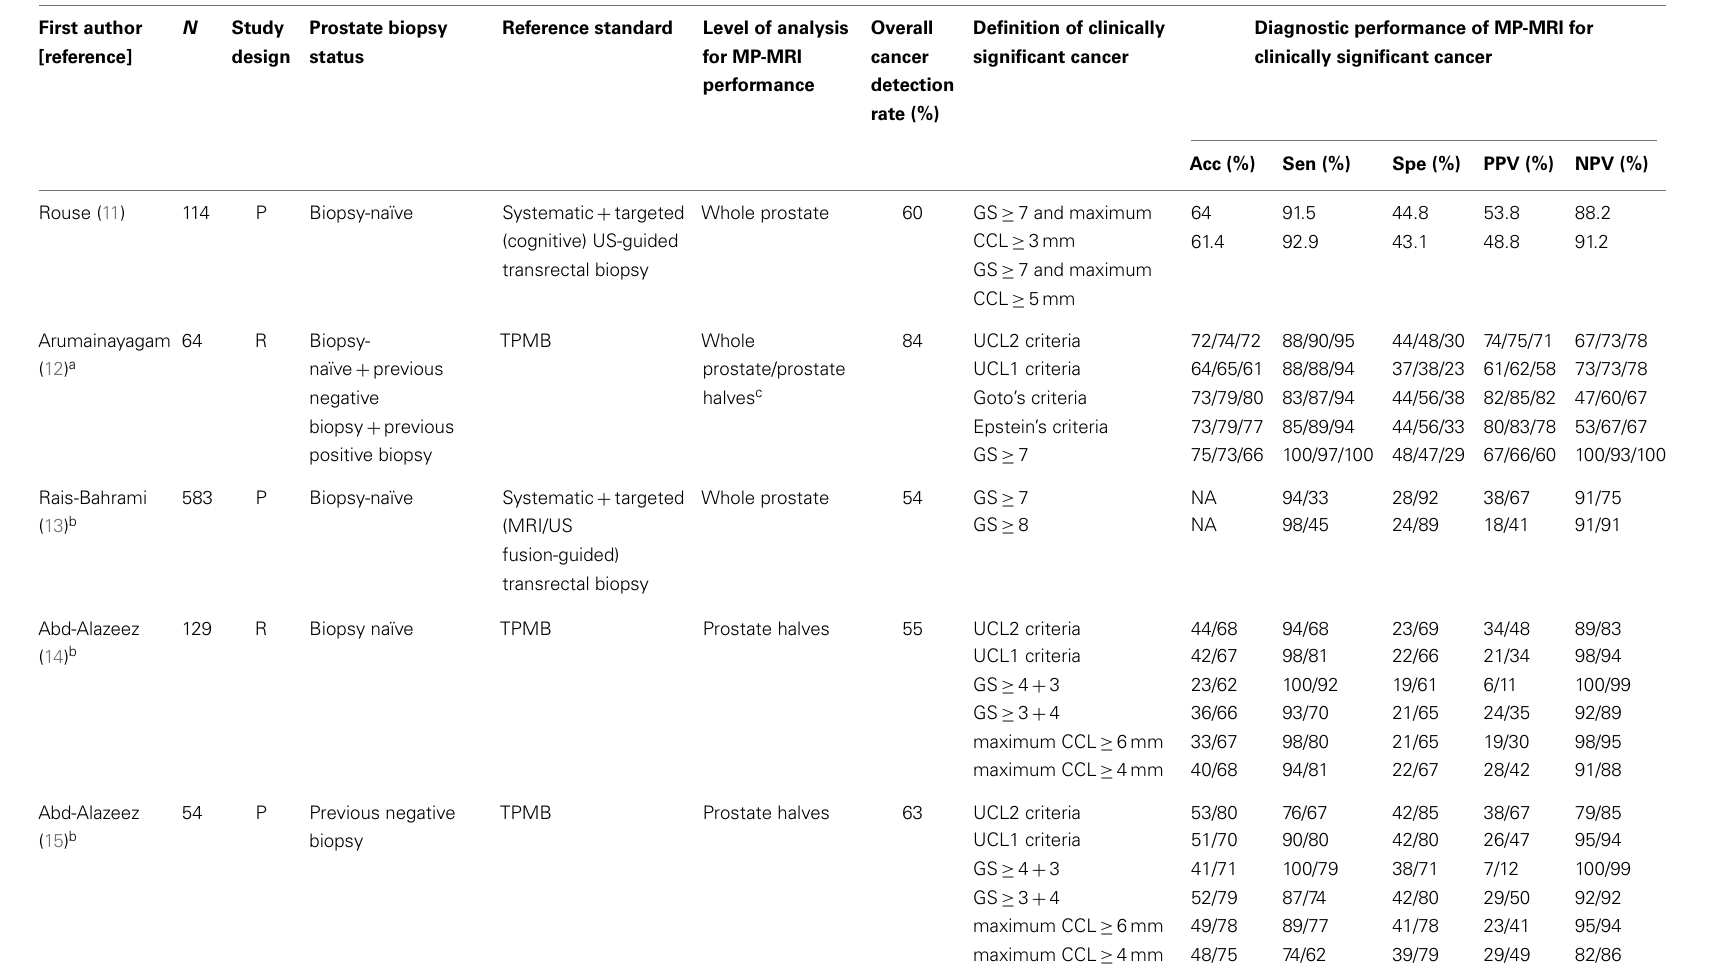
Table 1 | Main characteristics of the selected studies evaluating multi-parametric magnetic resonance imaging in detecting clinically significant prostate cancer and reporting full data on diagnostic accuracy